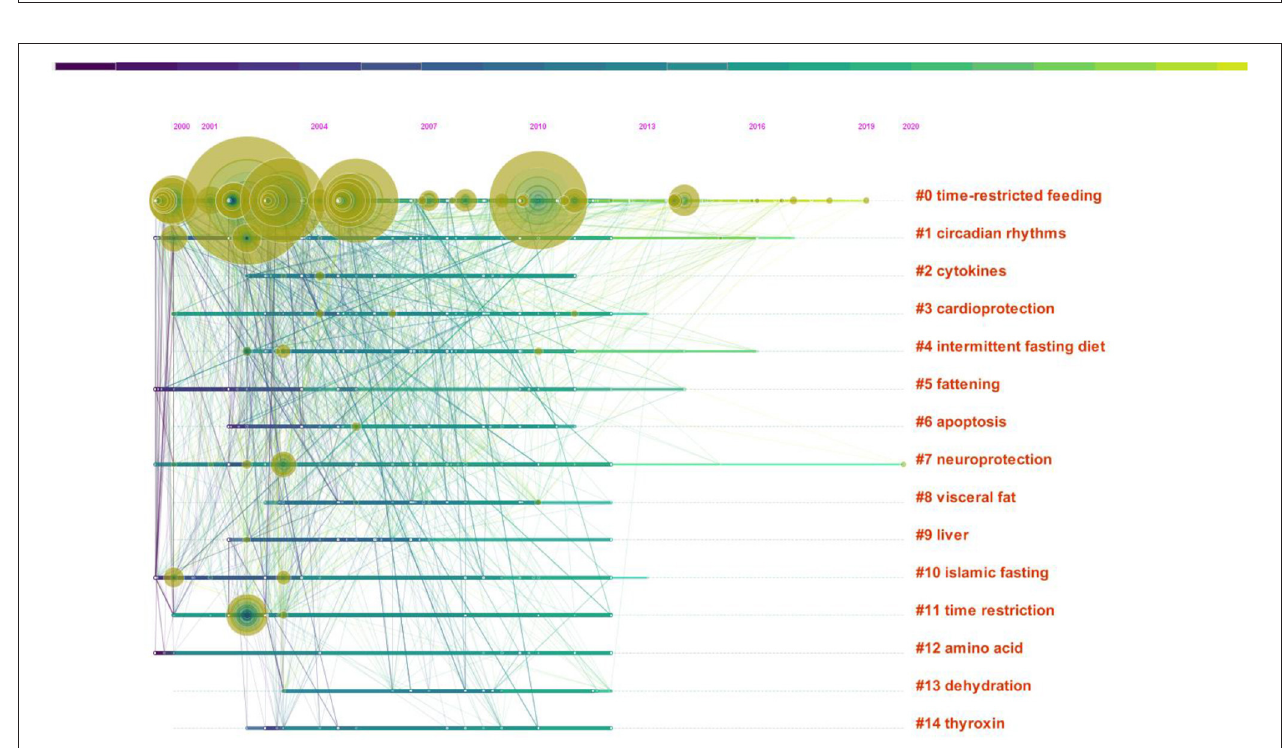
FIGURE 8 | Top 12 references with the strongest citation bursts.